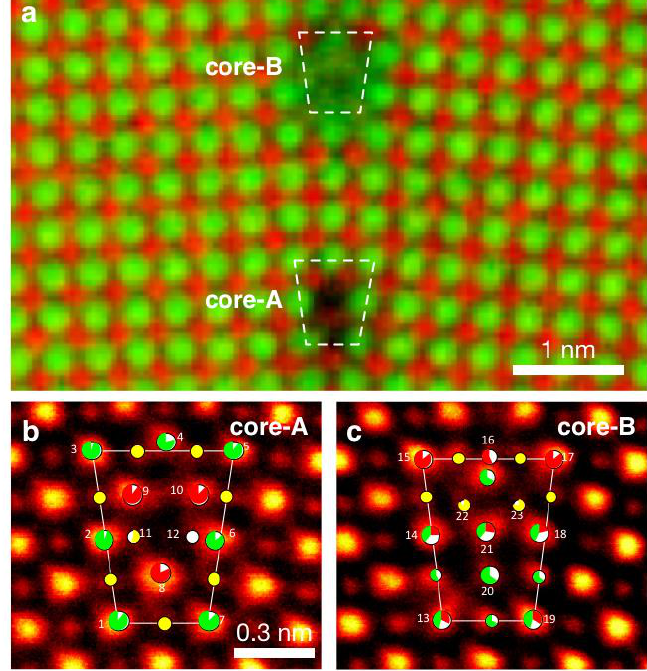
Figure 23. ( a ) Atomic-resolution EDS mapping obtained from the SrTiO 3 grain boundary. ( b , c ) Structure models of core-A and core-B are overlaid on the respective ABF STEM images.